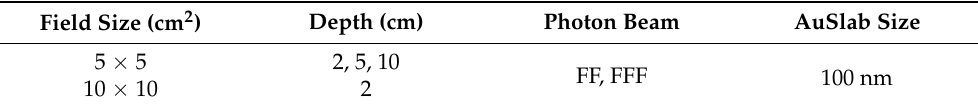
Table 2. Simulation parameters for field size and depth in water impact on dose